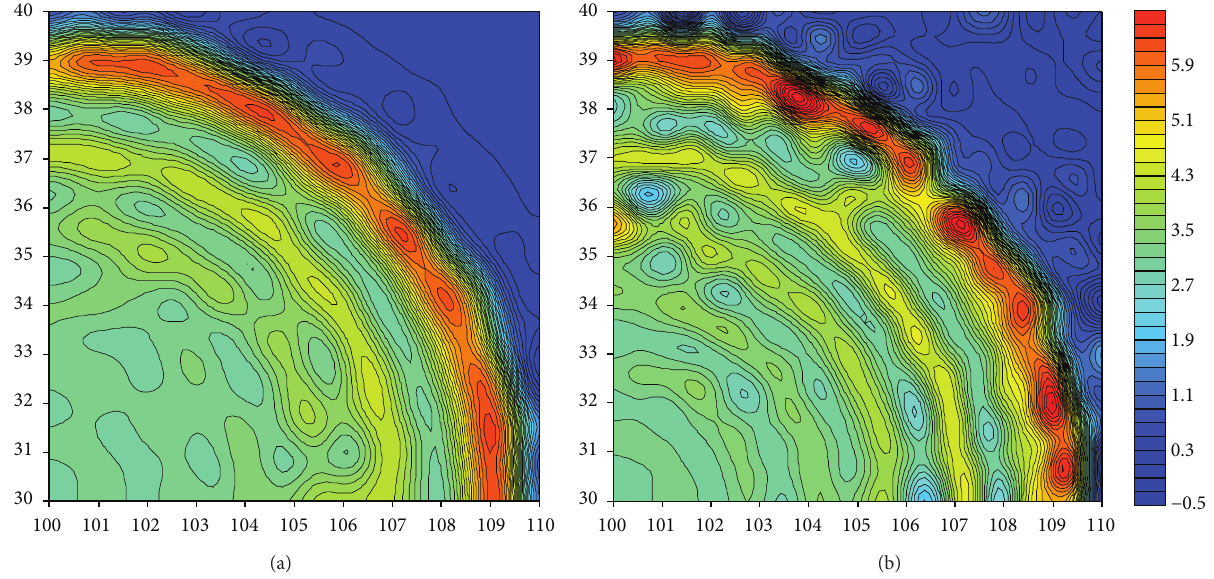
Figure 3: The analyzed temperature fields (unit: ∘ C) with 500 observations: analyzed fields using (a) GDF and (b) DF with 𝑎,𝑏 = 1.0 .